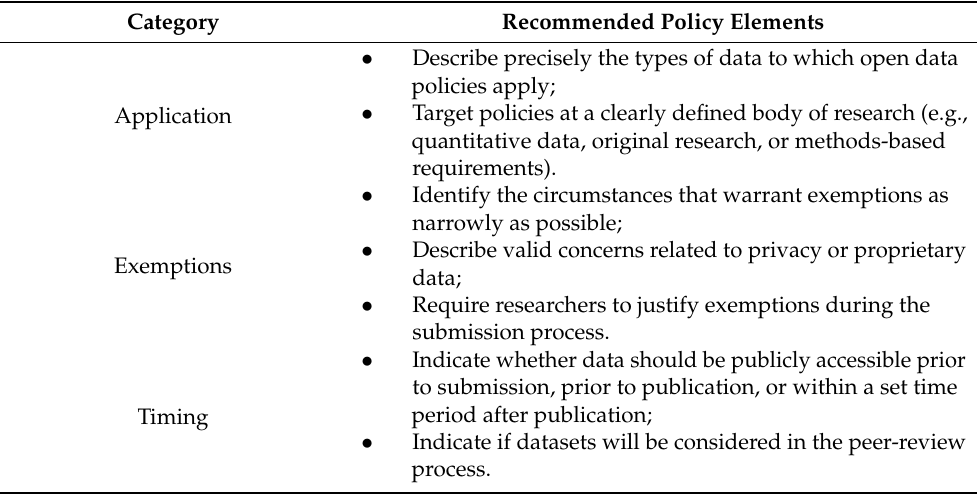
Table 2. Recommended journal open data policy